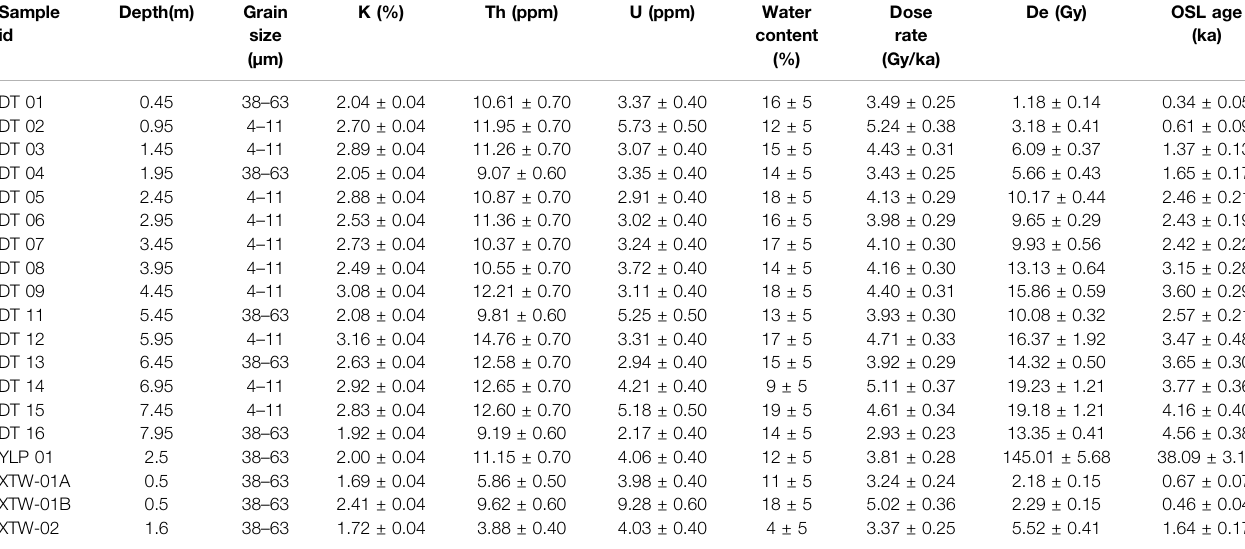
TABLE 1 | | Results of the OSL dating of sections DT, XTW and YLP in the Three Lakes. The OSL age of the DT10 sample could not be analyzed due to quartz de fi ciency. Sample id